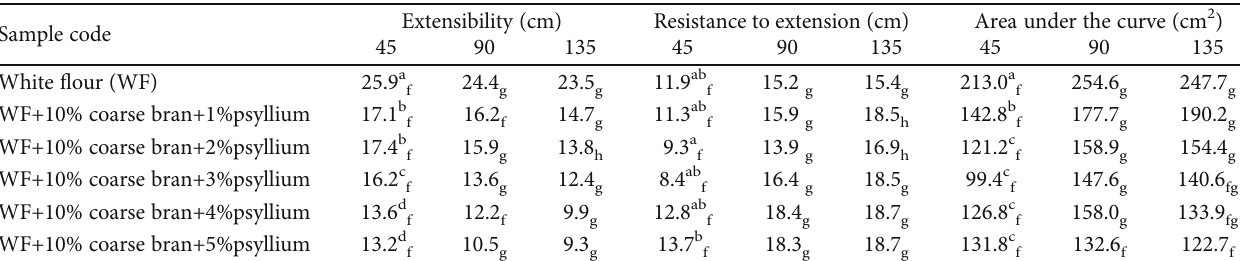
Table 11: Extensograph characteristics of dough made from fl our, coarse bran, and psyllium blends.